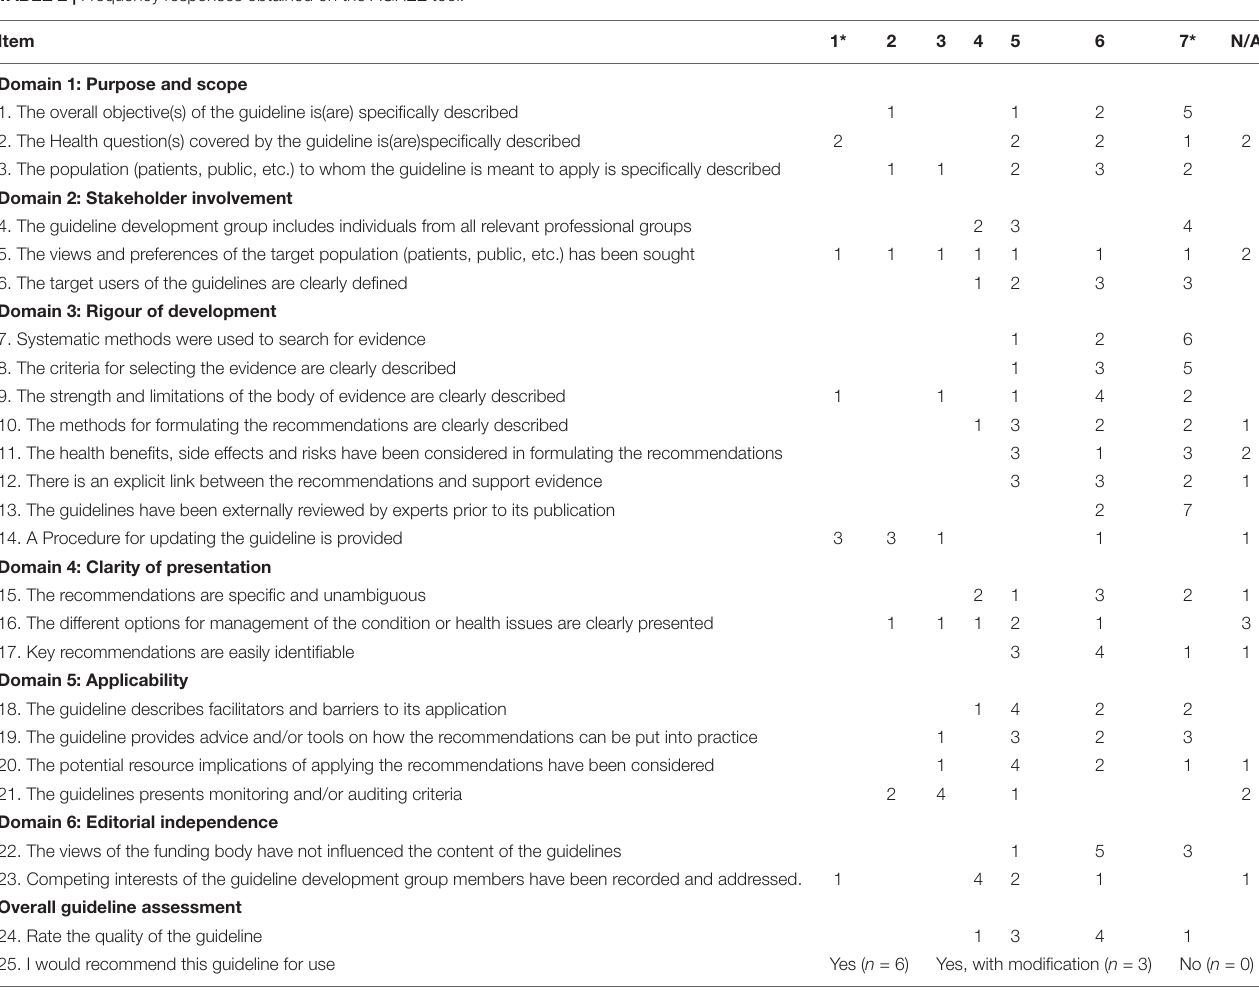
TABLE 2 | Frequency responses obtained on the AGREE